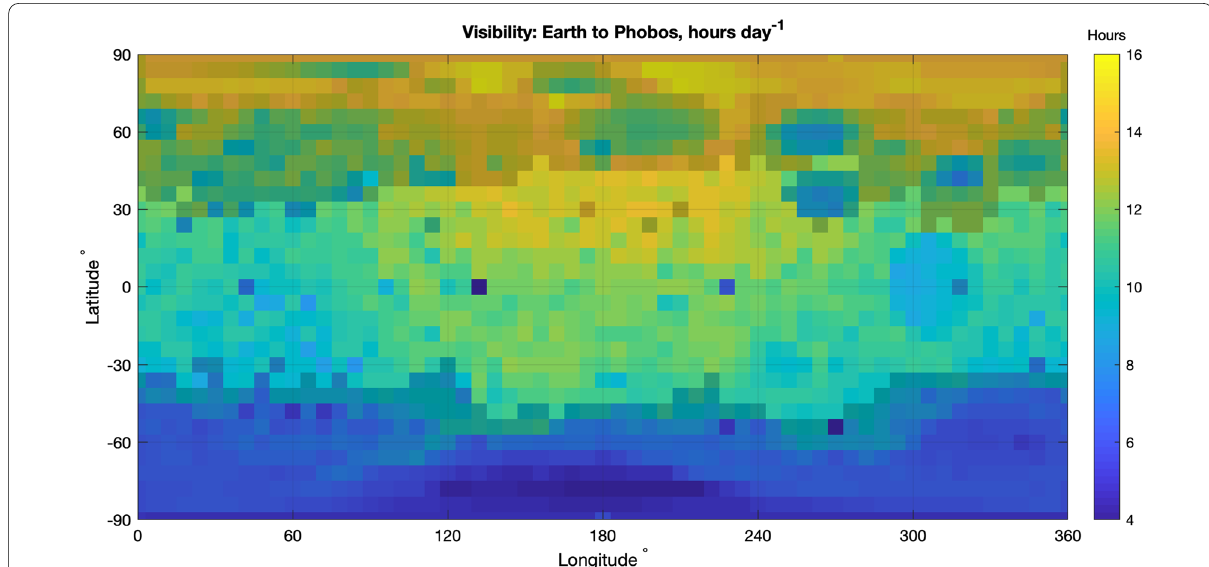
Fig. 4 Map of Phobos. Mean Earth to Phobos visibility hours per day averaged over the period (1 Jan 2030 – 18 Nov 2031). The shaded area represents locations where any single day in that period contains less than 6 hours visibility between Phobos and Earth, according to our data relay requirement in Table 1. The Mars‑facing longitude is at 0° (360°), while the anti‑Mars point is at 180° longitude